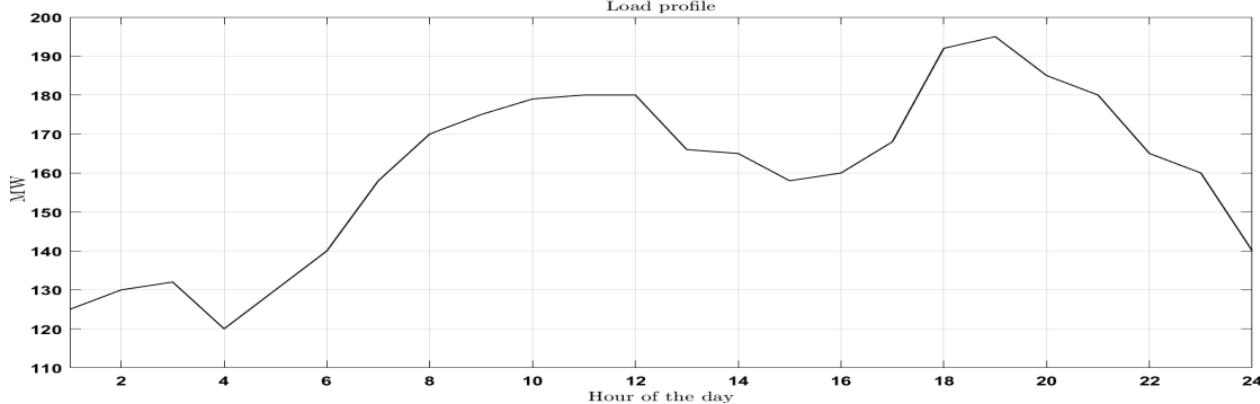
Figure 10. Modified IEEE 30 Bus system with a grid-connected microgrid. The typical load profile is shown in Figure 11.